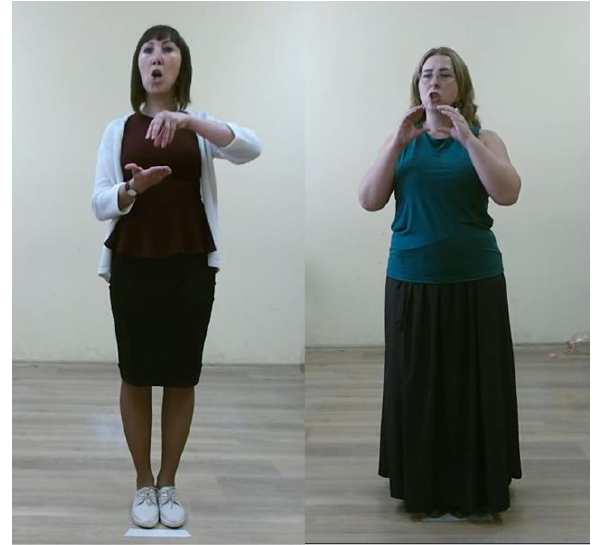
Figure 1. Example of signers during a recording session phoneme for acoustic speech, a viseme is the minimal distinguishable unit of visual speech. The number of visemes is language-dependent and for Russian there are 14-20 distinguishable speech units in different works. In the current